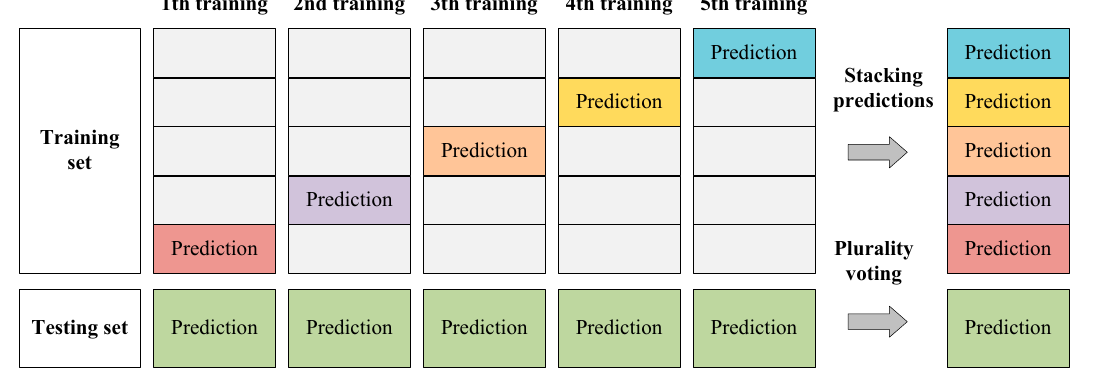
( d ) ( e ) Figure 4. Training losses over iterations of five semantic segmentation networks: ( a ) FCN-8s, ( b ) SegNet, ( c ) U-Net, ( d ) PSPNet, and ( e ) DeepLabv3+. 4.2. Softmax Regression-Based Ensemble Learning o f Semantic Segmentation Networks 4.2.1. Training and Testing Data of Ensemble Learnings Following Section 4.1, the predictions of the trained FCN-8s, SegNet, U-Net, PSPNet, and DeepLabv3+ are implemented on the testing set, and one part of the divided training set is reserved. The prediction time for each semantic segmentation network is recorded as 1 s for each image. Figure 5 shows the generative process of training and testing data for the softmax regression-based ensemble learning in each network. In the process, the